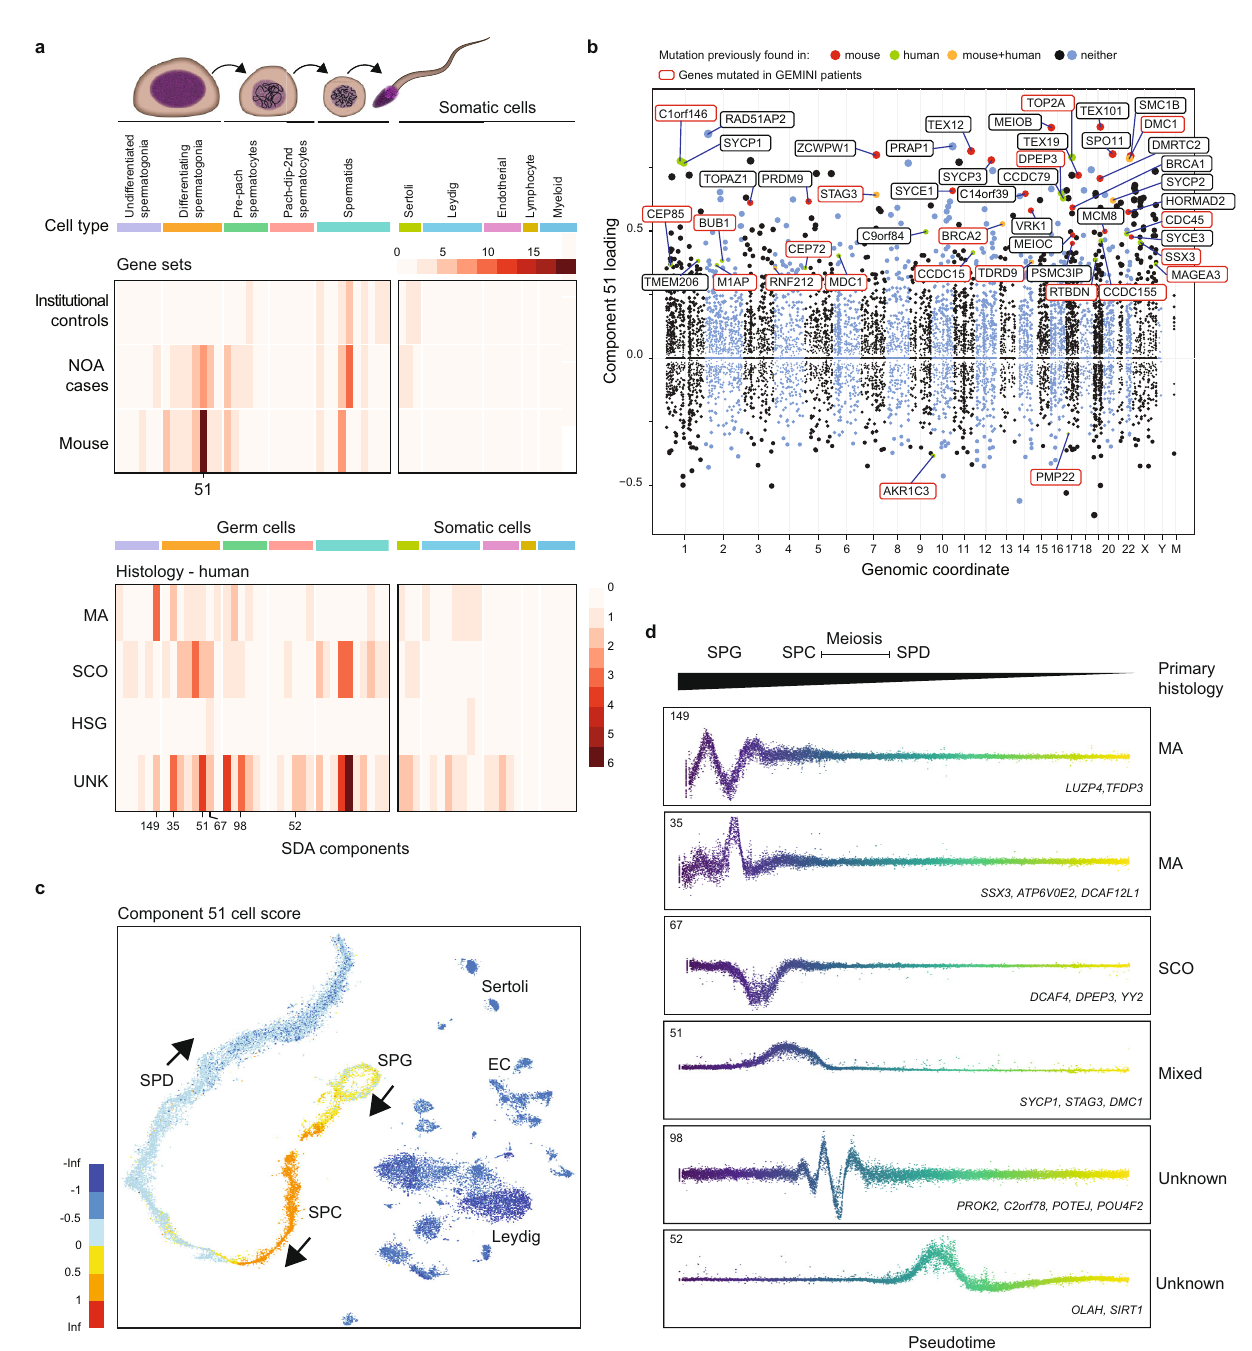
spermatocytes,SPDspermatids,UNKundeterminedhistology. b ExpressionofSDA component 51 visualized on a t-SNE representation of the human testis scRNA-seq dataset. This component is expressed in spermatogonia, and more highly in pre- leptotene spermatocytes. c Gene loadings for SDA component 51. Gene loadings re fl ect which genes are active in a component, with stronger positive or negative loadingsindicatinggreaterexpressionchangesinthecomponentcomparedtothe total dataset. d Germ cell expression of components with multiple gene loadings ordered by pseudotime, shown with representative genes and patient